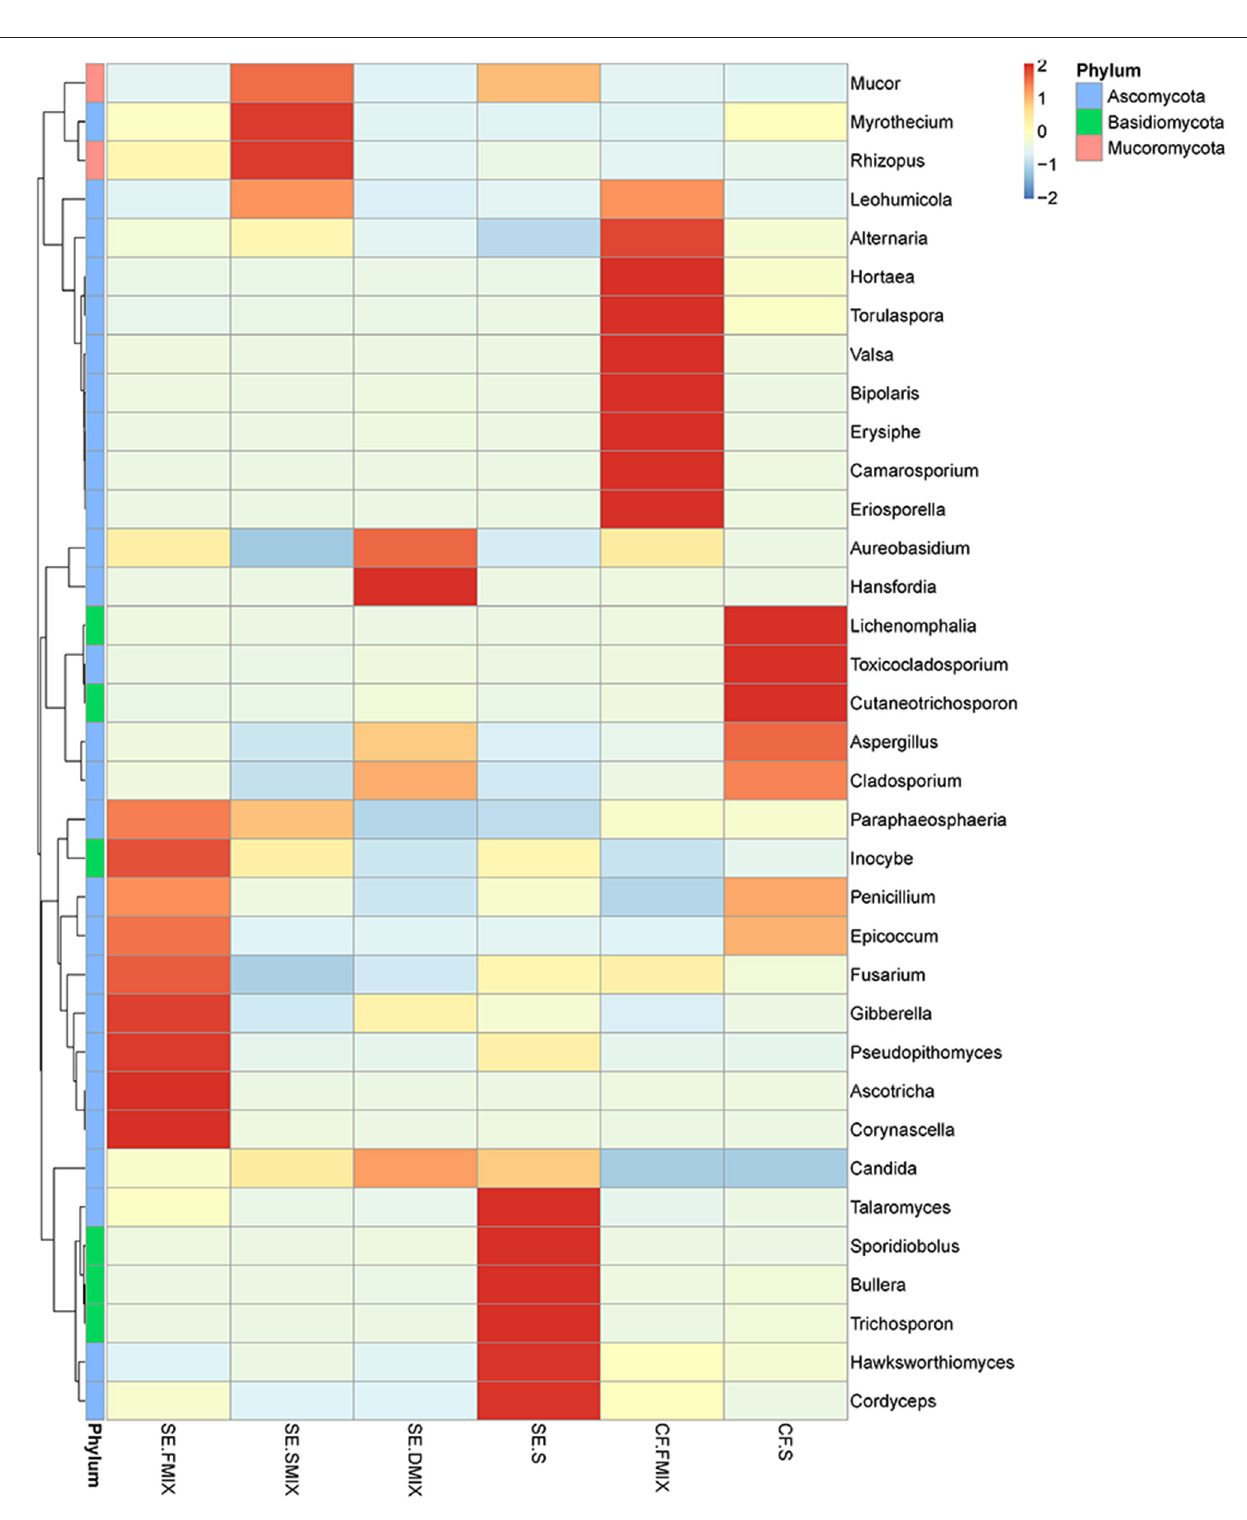
Frontiers in Pediatrics |